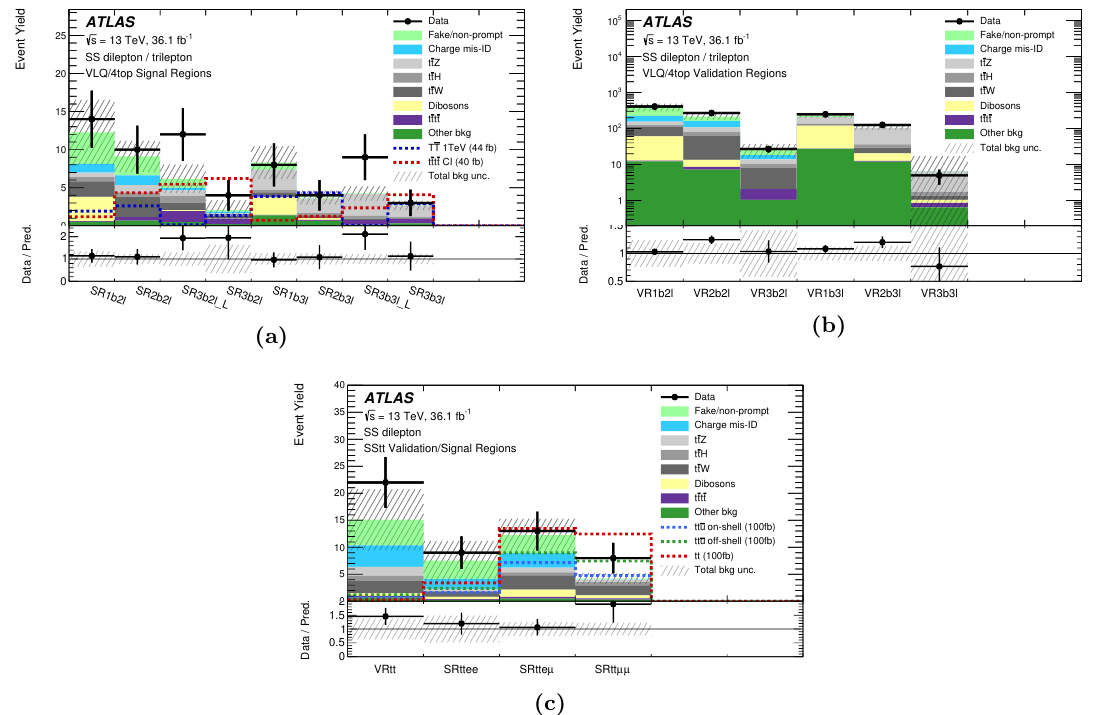
Figure 7 . Predicted background and observed data in (a) the signal regions and (b) validation regions for the vector-like quark and SM four-top-quark searches, and (c) in the signal and validation regions for the same-sign top-quark pair production search, along with the predicted yields for typical signals. The uncertainty, shown as the hashed region, includes both the statistical and systematic uncertainties from each background